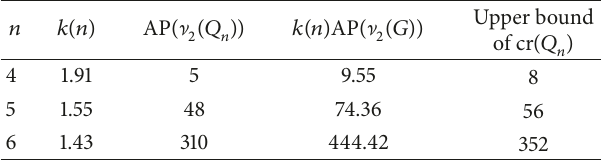
Table 2: The computable quantity 𝑘(𝑛) , the bound of ] 2 (𝑄 𝑛 ) , and the upper bound of cr (𝑄 𝑛 ) for 𝑛 = 4, 5, 6